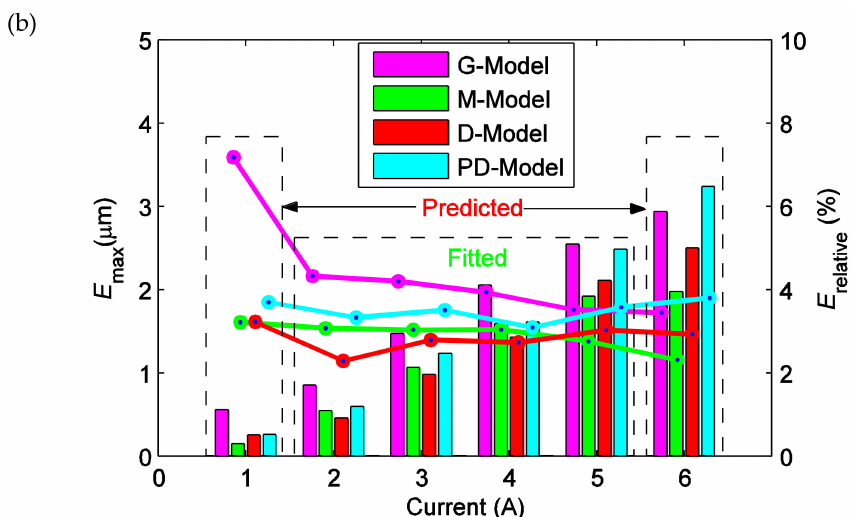
Figure 13. Displacement di ff erence between the experimental results and the fitted, predicted results of the established ISSF-Duhem model and the PD-Model when the magnetostrictive actuator under 1 Hz harmonic input with di ff erent currents: ( a ) MSE versus current and ( b ) E max and E relative versus current. E max : bars, E relative : lines. G-Model: the ISSF-Duhem model with Grompertz function-based shape function; M-Model: the ISSF-Duhem model with modified hyperbolic tangent function-based shape function; D-Model: the ISSF-Duhem model with a one-sided dead-zone operator-based shape function; PD-Model: the modified Prandtl–Ishlinskii model with a one-sided dead-zone